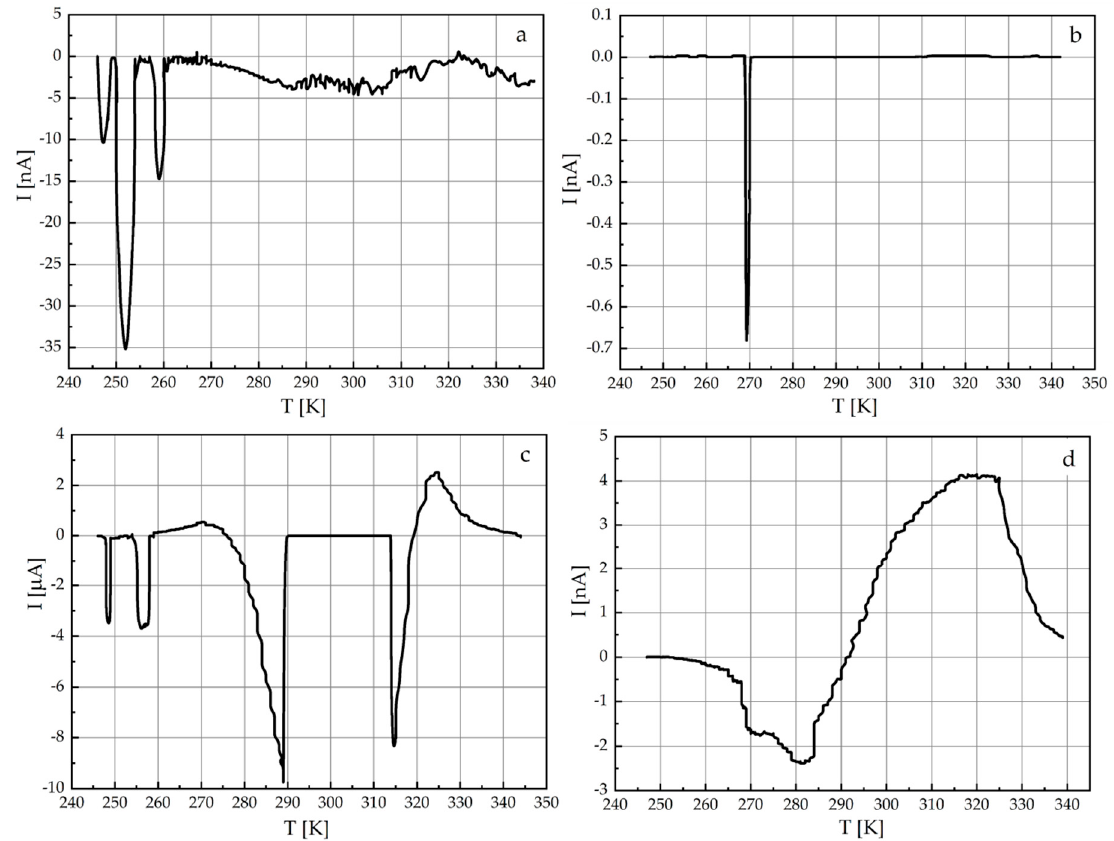
Figure 14. Current spectra of thermostimulated depolarisation measured perpendicularly to layers of the non-intercalated 4-fold expanded GaSe matrix ( a ), synthesized hierarchal GaSe ( SC(NH 2 ) 2 ) ( b ) GaSe ( SmCl 3 ) ( c ) and GaSe ( SC(NH 2 ) 2 ( SmCl 3 )) ( d ) structures.